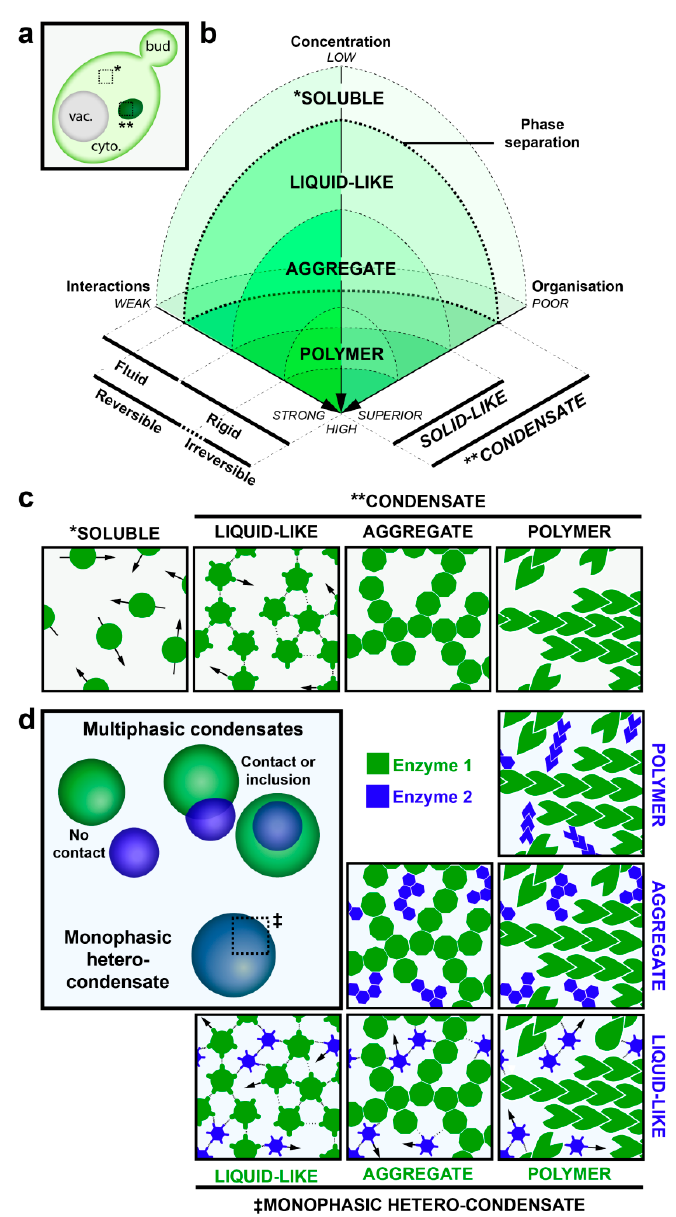
Figure 1. Biophysical properties of protein condensates. ( a ) Schematic representation of phase separation of proteins in yeast. Phase separation allows components to undergo a transition from soluble (*), diffuse localization to one or a few molecular condensates (**) that appear as foci in light microscopy [43,44]. ( b , c ) This phase transition and the type of condensates depend on three component properties: The concentration, the strength of component-component interaction and the intrinsic organization. Phase transition occurs when components reach a critical saturation due to increases of local concentrations and/or augmentation of component-component interactions relative to solvent-component interactions. Weak electrostatic intermolecular interactions are more likely to lead to liquid-like droplets which require little energy input to dissolve and thus components in these condensates are quite mobile. Stronger intermolecular interactions generate solid-like foci which require a high energy input to dissolve and thus components of these condensates acquire a more rigid aspect. The level of organization within the solid-like condensates distinguishes aggregates, unorganized condensates, from polymers, which are well organized. ( d ) Condensates can contain multiple components (hetero-condensate) and can possess different molecular organizations (multi-phasic, ‡), as illustrated.